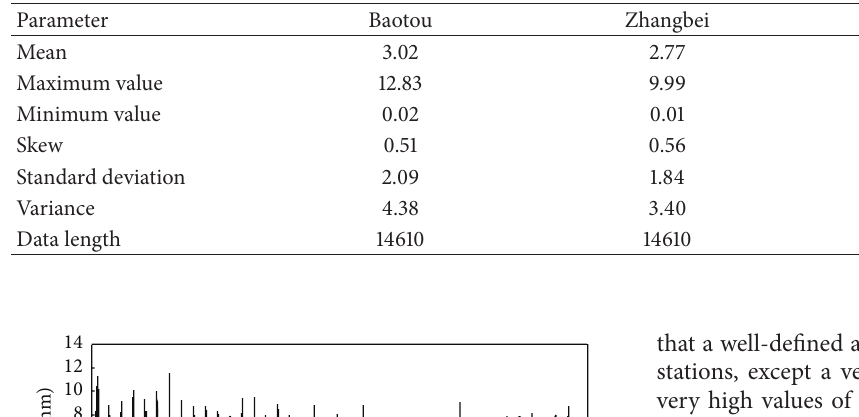
Table 2: Statistics of daily reference evapotranspiration data from different stations selected in the present study.